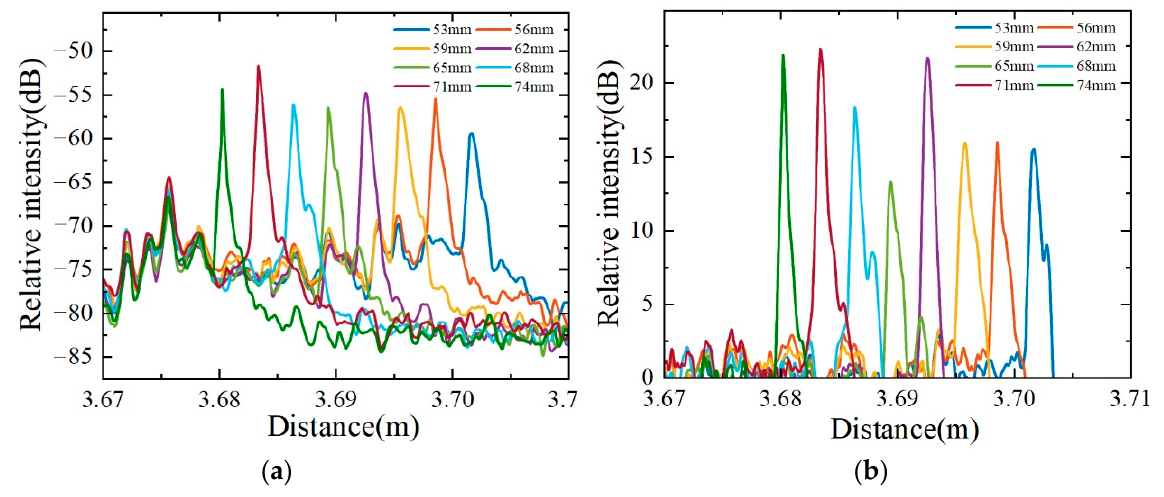
Figure 6. Reflection peak drift with liquid level from 53 to 74 mm. ( a ) Original reflection peaks in the distance domain; ( b ) distance domain drift after removing spurious peaks.